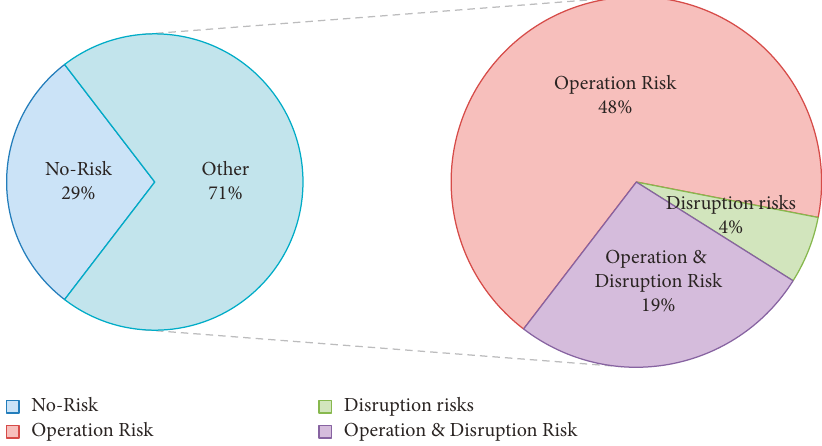
Figure 7: Display of operational risk and disruption risk